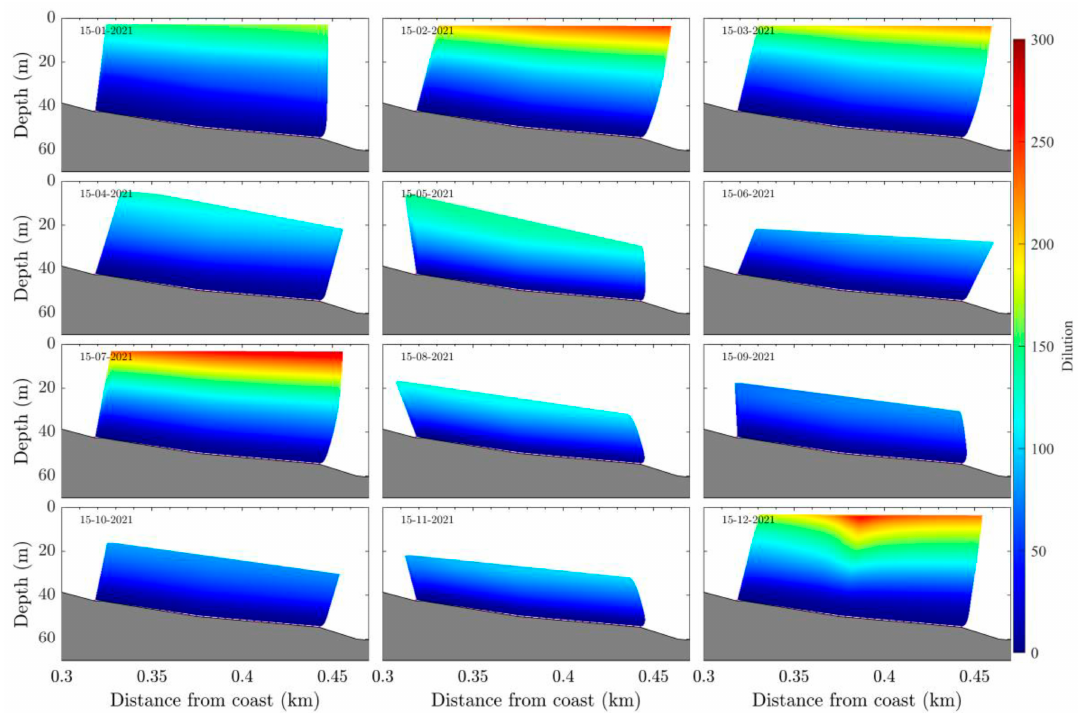
Figure 11. Plume merge from the 32 diffusers of Santa Marta´s submarine outfall. Color bar shows the dilution level with wave effects.